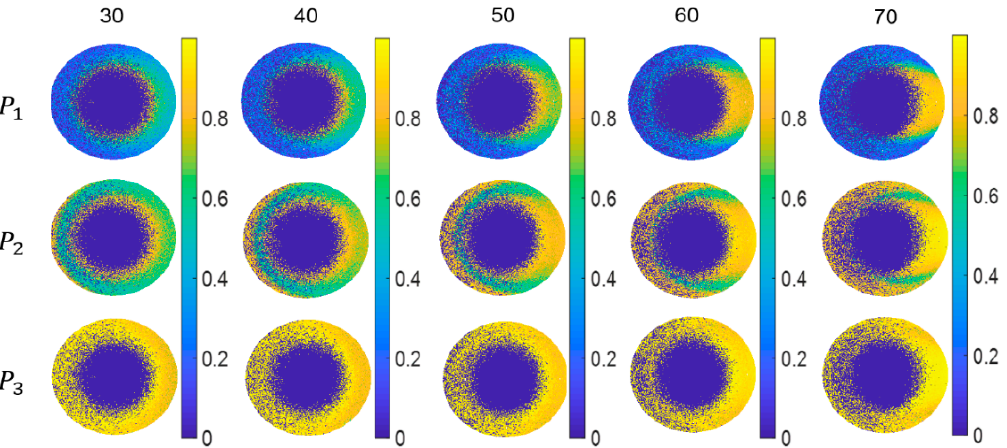
Figure 8. P 1 , P 2 , P 3 of each grid in the upper hemisphere with the incident angle change for the Cu